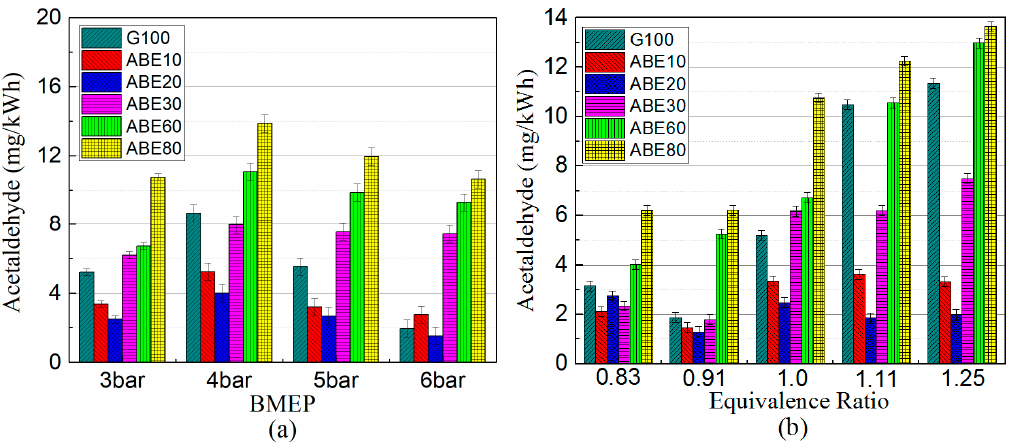
Figure 6. 1,3-Butadiene emissions at ( a ) stoichiometric conditions under different BMEP, and at ( b ) 3 bar BMEP under different equivalence ratios.